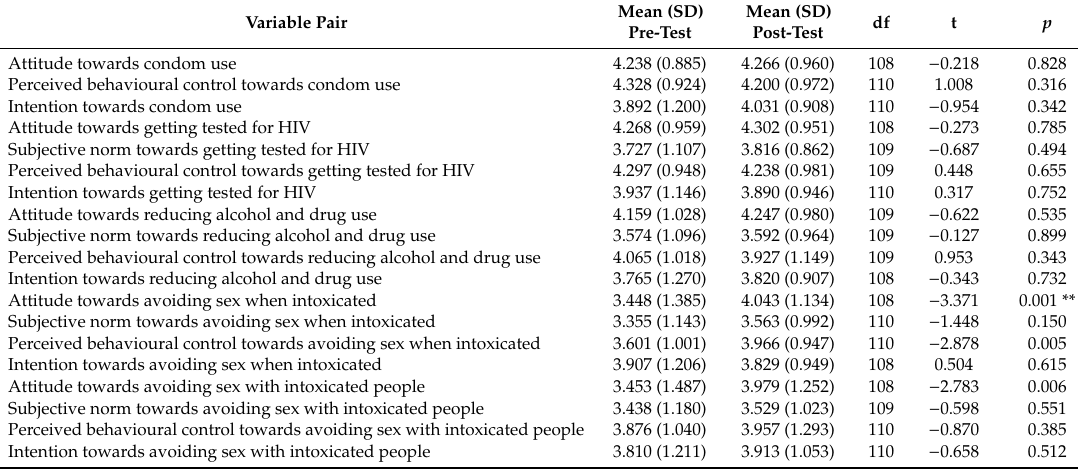
Table 5. Paired samples T-tests showing pre-test versus post-test scores on the variables for the study 2